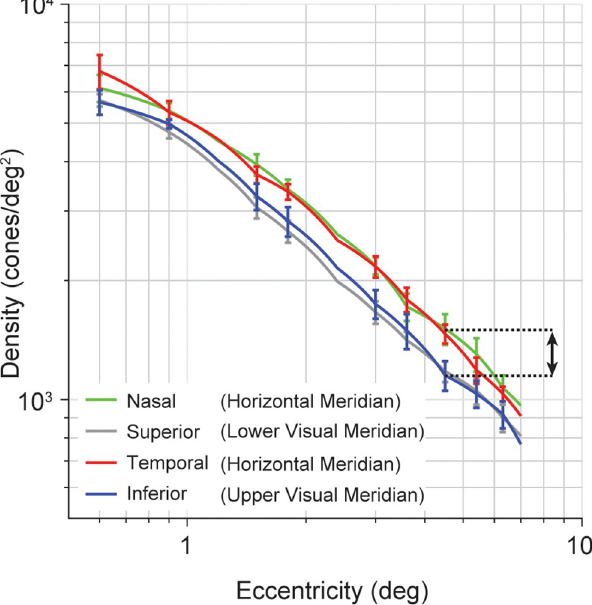
Fig 2. Variations in human cone density as a function of eccentricity and polar angle. Cone density falls off sharply with eccentricity, and also varies between horizontal and vertical retinal axes. Data are pooled across both eyes. Error bars represent standard error across 10 observers. Arrow indicates difference in cone density between horizontal and upper visual meridian at 4.5˚ eccentricity (matching Fig 1). Figure recomputed with data from observers between 22– 35 years old (‘Group 1’) reported by Song et al.